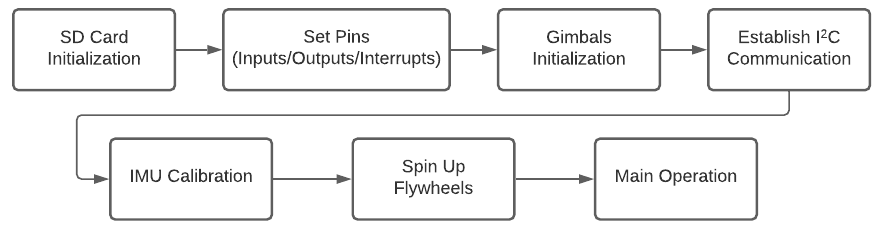
Figure 7. Air bearing operation flow